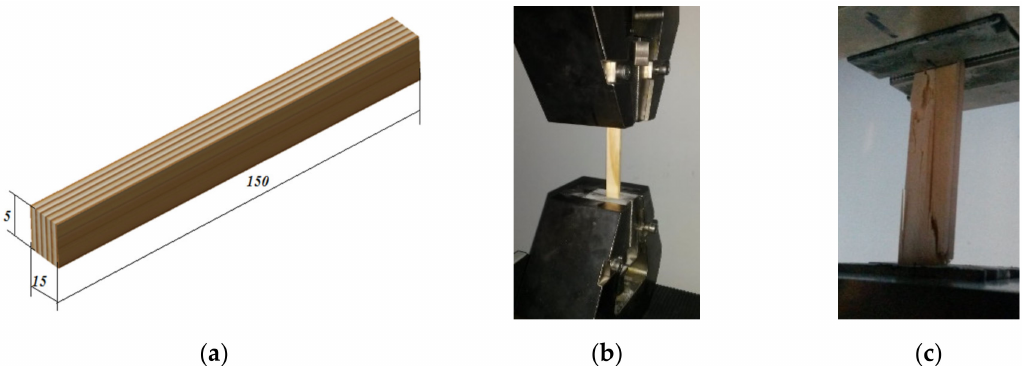
Figure 2. Experimental set-up: ( a ) the geometry of tested samples; ( b ) details of the sample in clamping jaws of the testing machine during the symmetric cyclic loading to tensile-compression; ( c ) Failure mode of sample tested to cyclic loading.